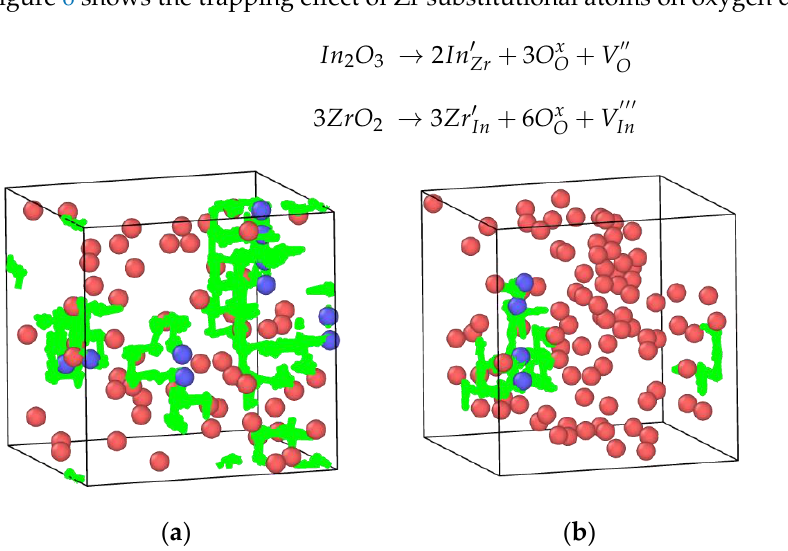
Figure 5. Substitutional indium atoms in red, interstitial oxygen atoms in the last data dump of the simulation in blue, and the diffusion paths of those oxygen atoms in green. ( a ) 60 substitutional In ( b ) 90 substitutional In.